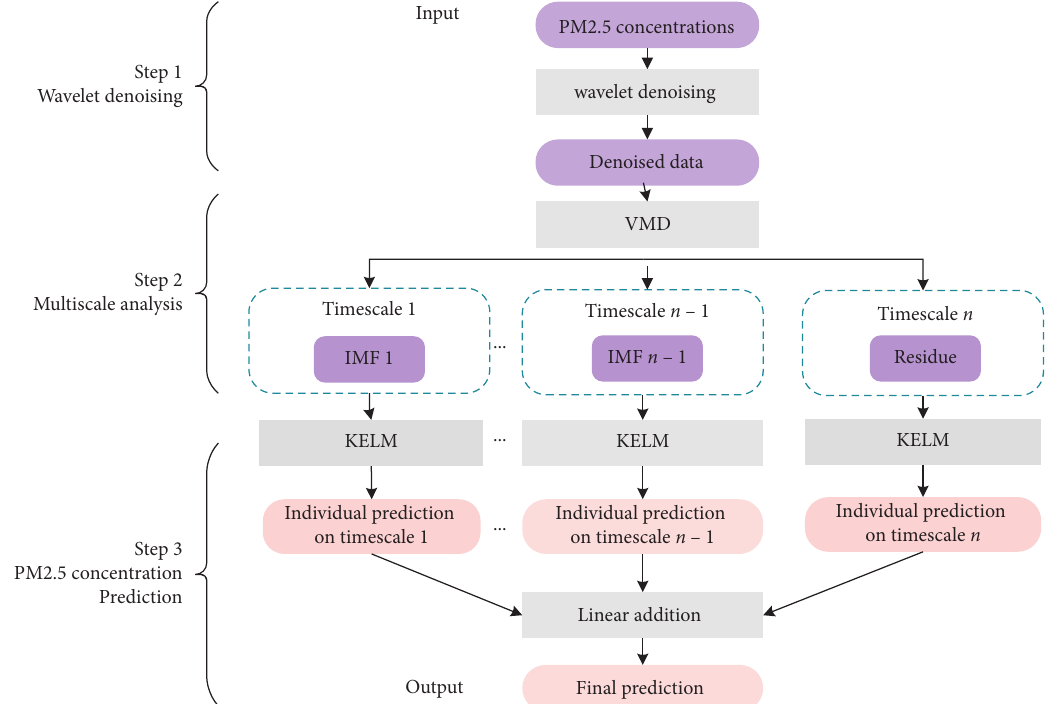
Figure 1: The framework of the hybrid